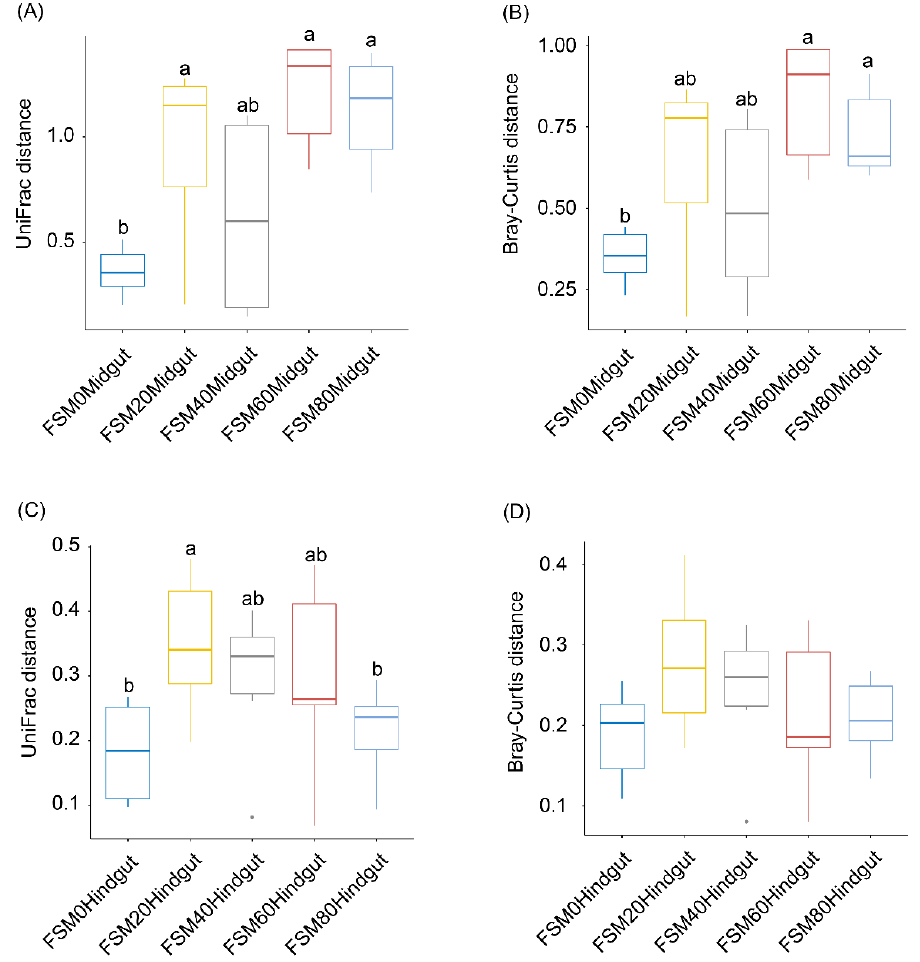
Figure 4. β -diversity indices of crucian carp ( Carassius auratus ) gut microbiota. ( A ) UniFrac distances of C. auratus midgut microbiota; ( B ) Bray–Curtis distances of C. auratus midgut microbiota; ( C ) UniFrac distances of C. auratus hindgut microbiota; ( D ) Bray–Curtis distances of C. auratus hindgut microbiota. The numbers in the sample names indicate the proportion of fermented soybean meal instead of fish meal. The difference in the lower case letters above the boxes indicates that there was a significant difference between the two groups ( p <